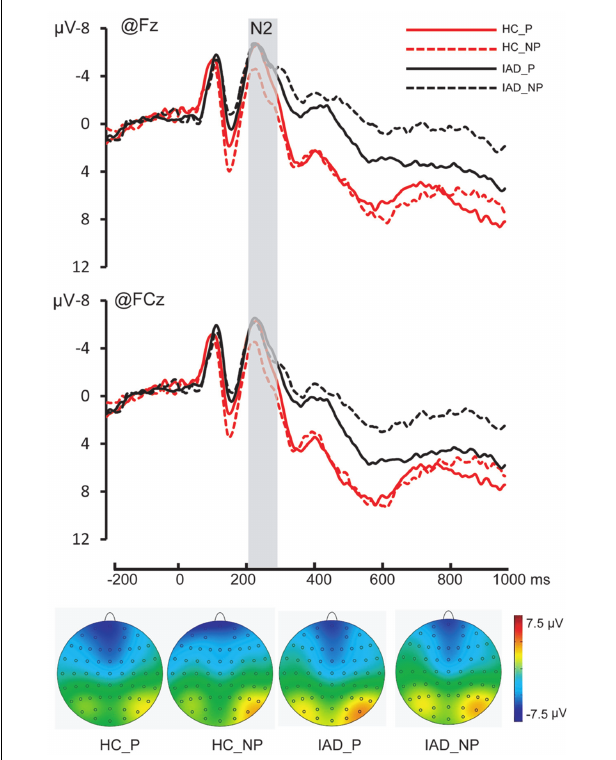
FIGURE 2 | The Grand average on Fz and FCz and topography of N2 in all four conditions [Painful pictures in HC group (HC_P); Non-painful pictures in HC group (HC_NP); Painful pictures in IAD group (IAD_P); and Non-painful pictures in IAD group (IAD_NP)]. The time window of the topography was corresponding to the gray square covered